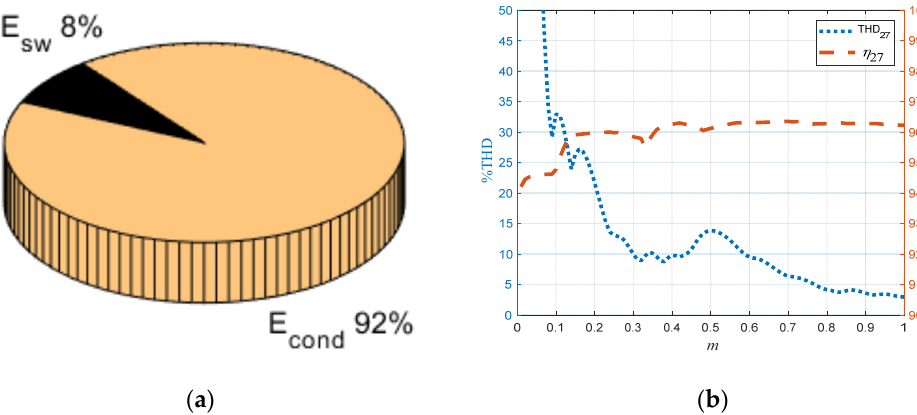
Figure 10. ( a ) Semiconductor losses distribution for m = 1.0, ( b ) comparison between THD va and efficiency and 27 levels single — phase asymmetric inverter without regeneration, for all m.